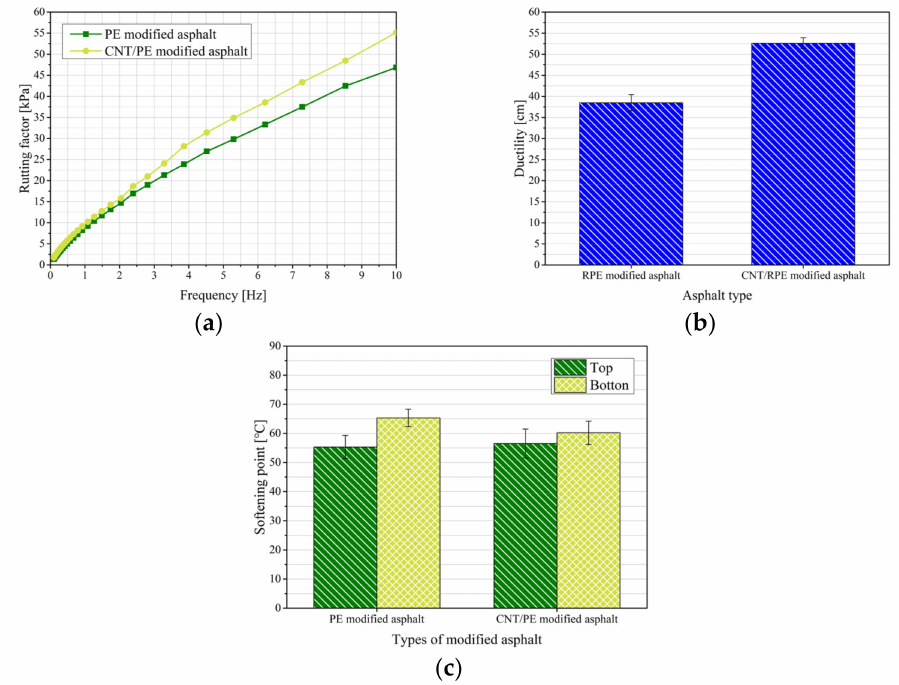
Figure 9. Properties of RPE-modified asphalt and CNT/RPE-modified